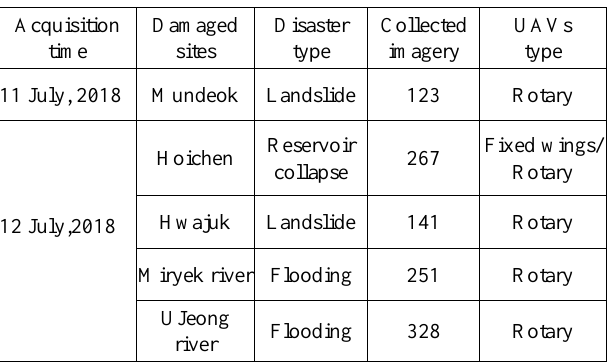
Table 3. Aerial imagery of damaged areas acquired from